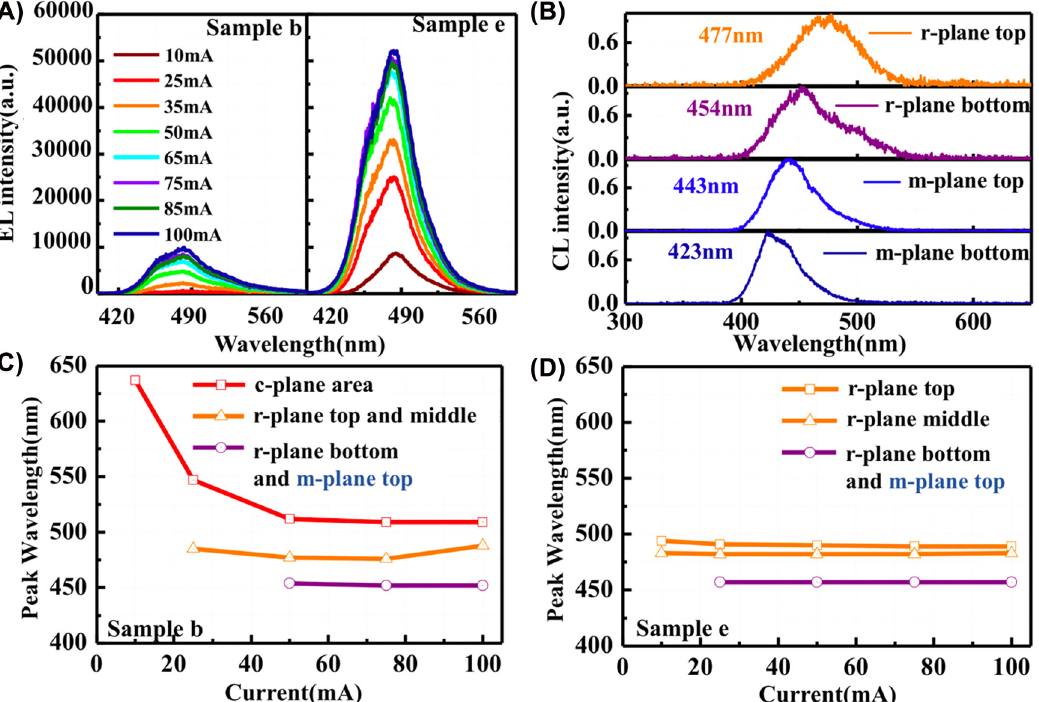
Figure 4: Comparison of EL spectra and the corresponding CL measurement results of samples b and e. (A) EL spectra in sample b and e measured under different injection current. (B) CL spectra acquired at (1–101) plane top, (1–101) plane bottom, (10–10) plane top, and m -plane bottom of the NWs. Panels (C) and (D) show the EL peak wavelengths derived from Gaussian fitting at each injection current for samples b and e, respectively. The emission peaks are assignable to different positions of the NWs. The (1–101) and (10–10) planes of NWs are indicated as ‘‘ r -plane’’ and ‘‘ m -plane’’ in the figures,